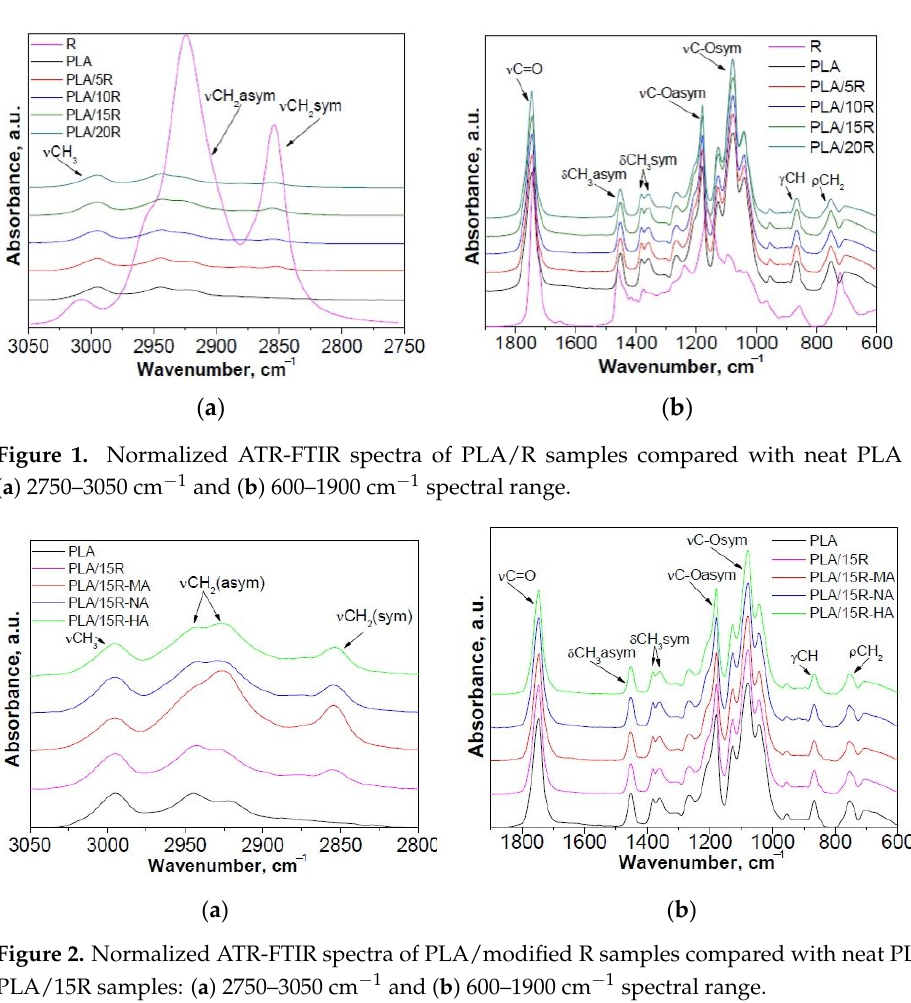
metrical valence vibrations of C–O–C of the aliphatic chain). The band at 868 cm − 1 can be assigned to the amorphous phase, while the band at 755 cm − 1 to the crystalline phase [42,43].